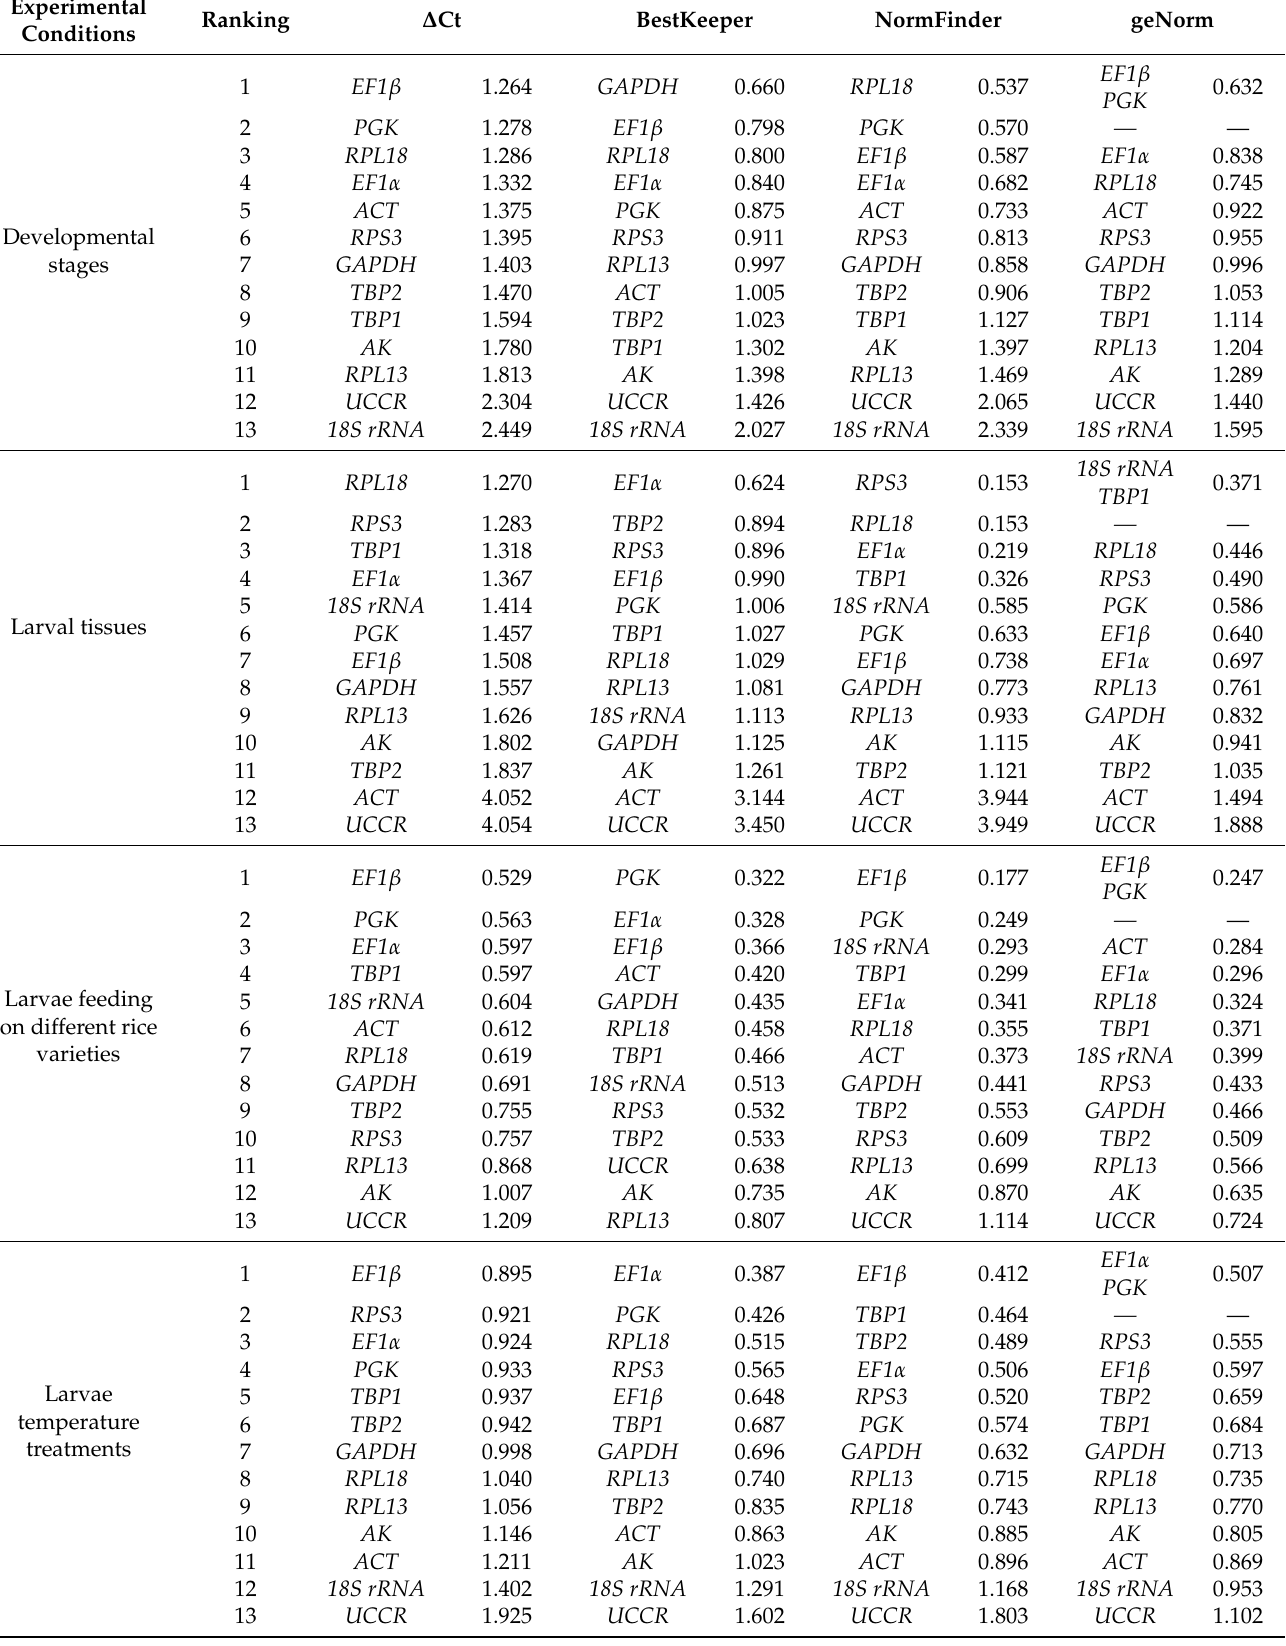
Table 2. Ranking of the candidate reference genes in C. medinalis under different